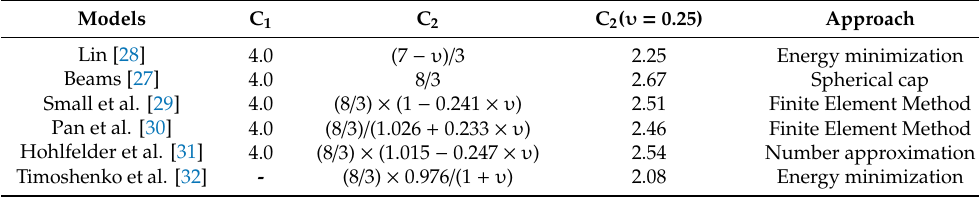
Table 1. C 1 and C 2 coefficients for circular membranes.